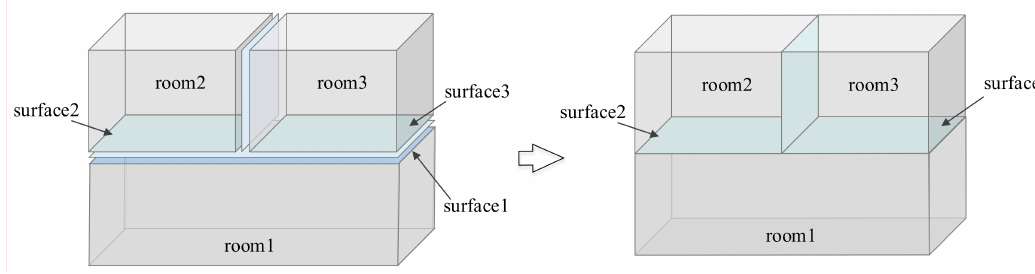
Figure 13. Maximal segmentation of surfaces.